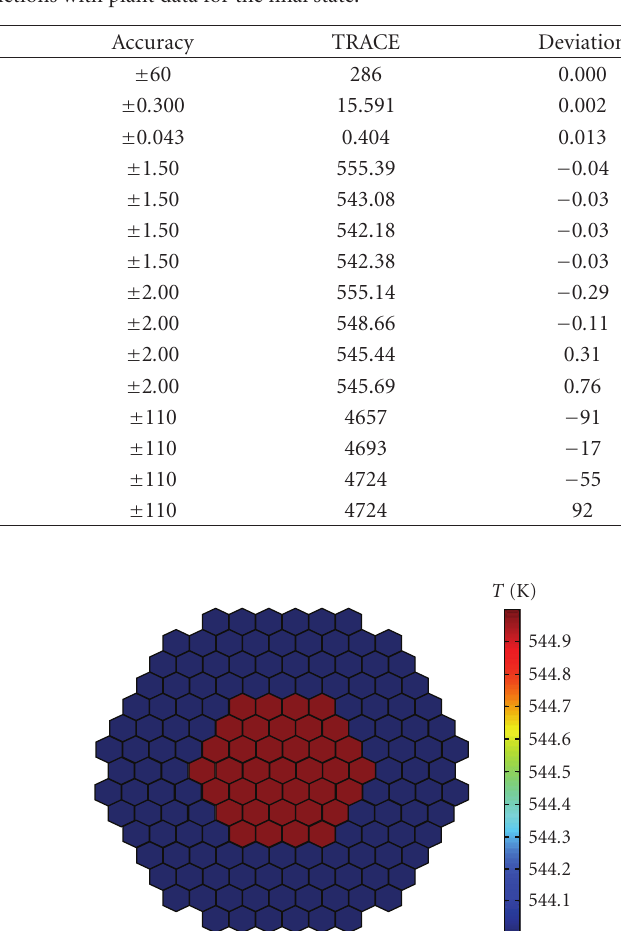
Table 4: Comparison of TRACE predictions with plant data for the final state.